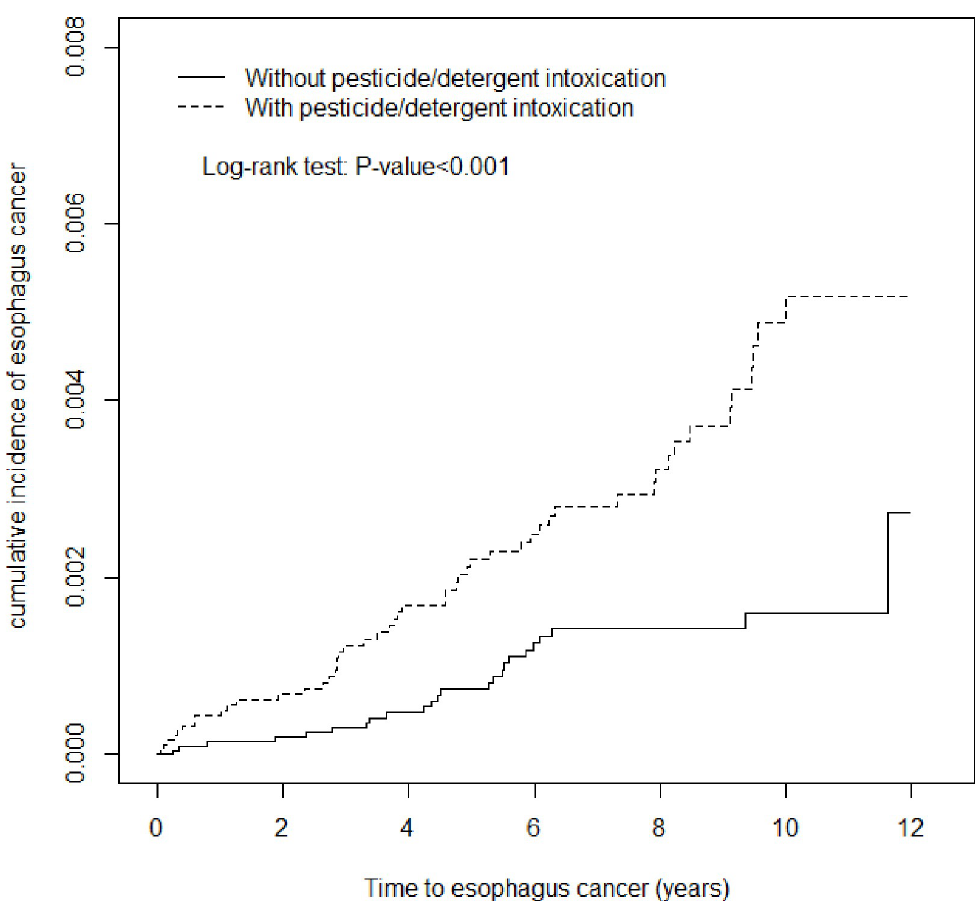
Fig 1. Cummulative incidence comparison of esophagus cancer in patients with (dashed line) and without (solid line) pesticide/detergent intoxication.